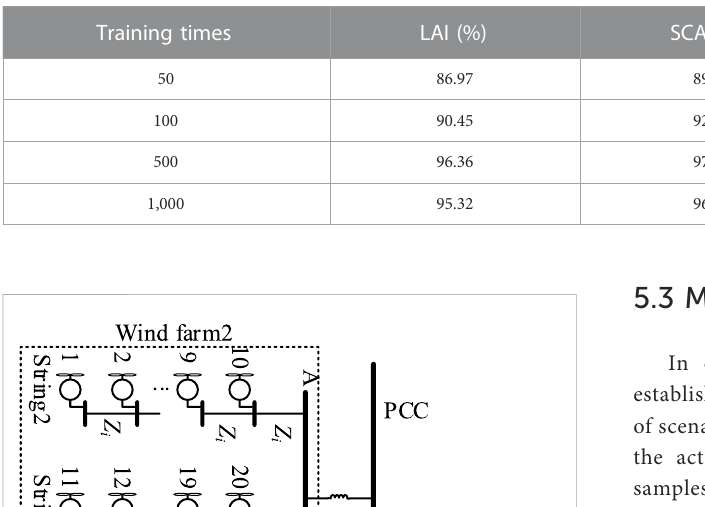
TABLE 1 Training results with different epochs.